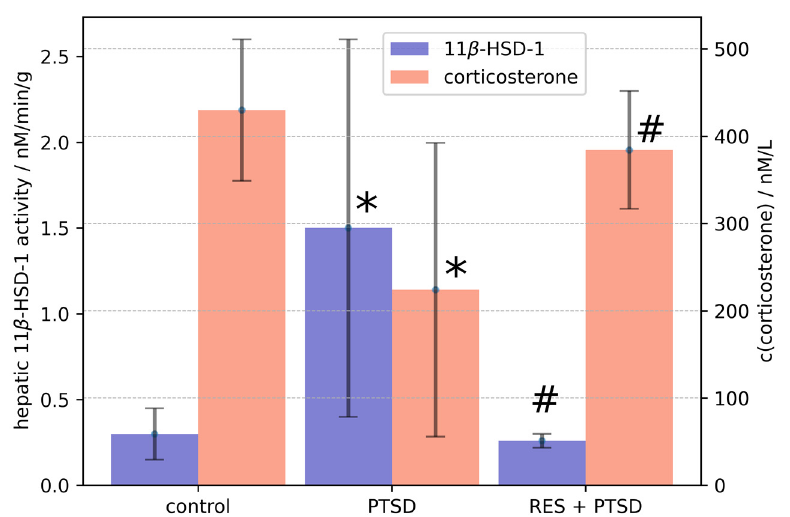
Figure 2. Effect of resveratrol treatment on PTSD-induced changes in hepatic 11 β -HSD-1 activity and plasma corticosterone concentration. Graph is plotted as mean values ± SD. Statistical analysis included one-sided ANOVA. Significant values are expressed as * = significant difference with control, # = significant difference between PTSD and RES + PTSD groups.